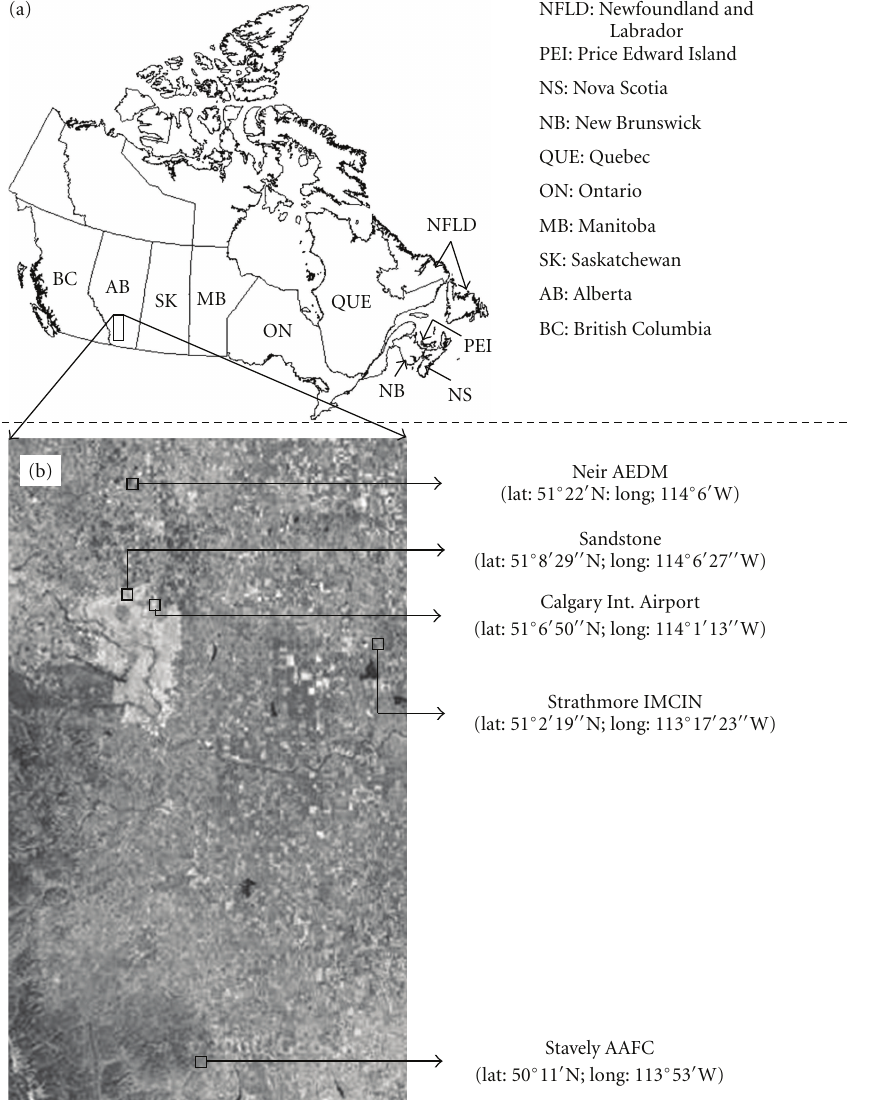
Figure 1: Location of: (a) the ten provinces in Canada; and (b) three sites (Neir AEDM, Strathmore IMCIN, and Stavely AAFC) in the province of Alberta, where the incident solarradiationregimes were modeled and validated and alsothe portion of the residential community of “Sandstone,” where the simulation of the solar energy was